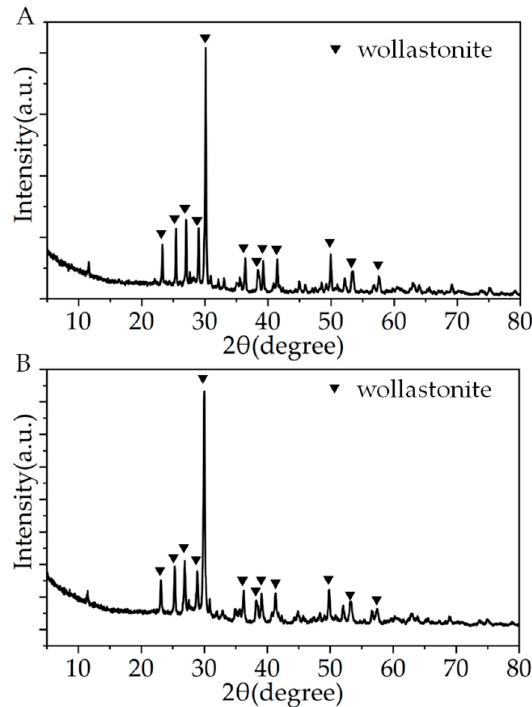
Figure 3. XRD patterns of the CSi-Mg samples sintered at 1150 °C ( A ) and 1225 °C ( B ).